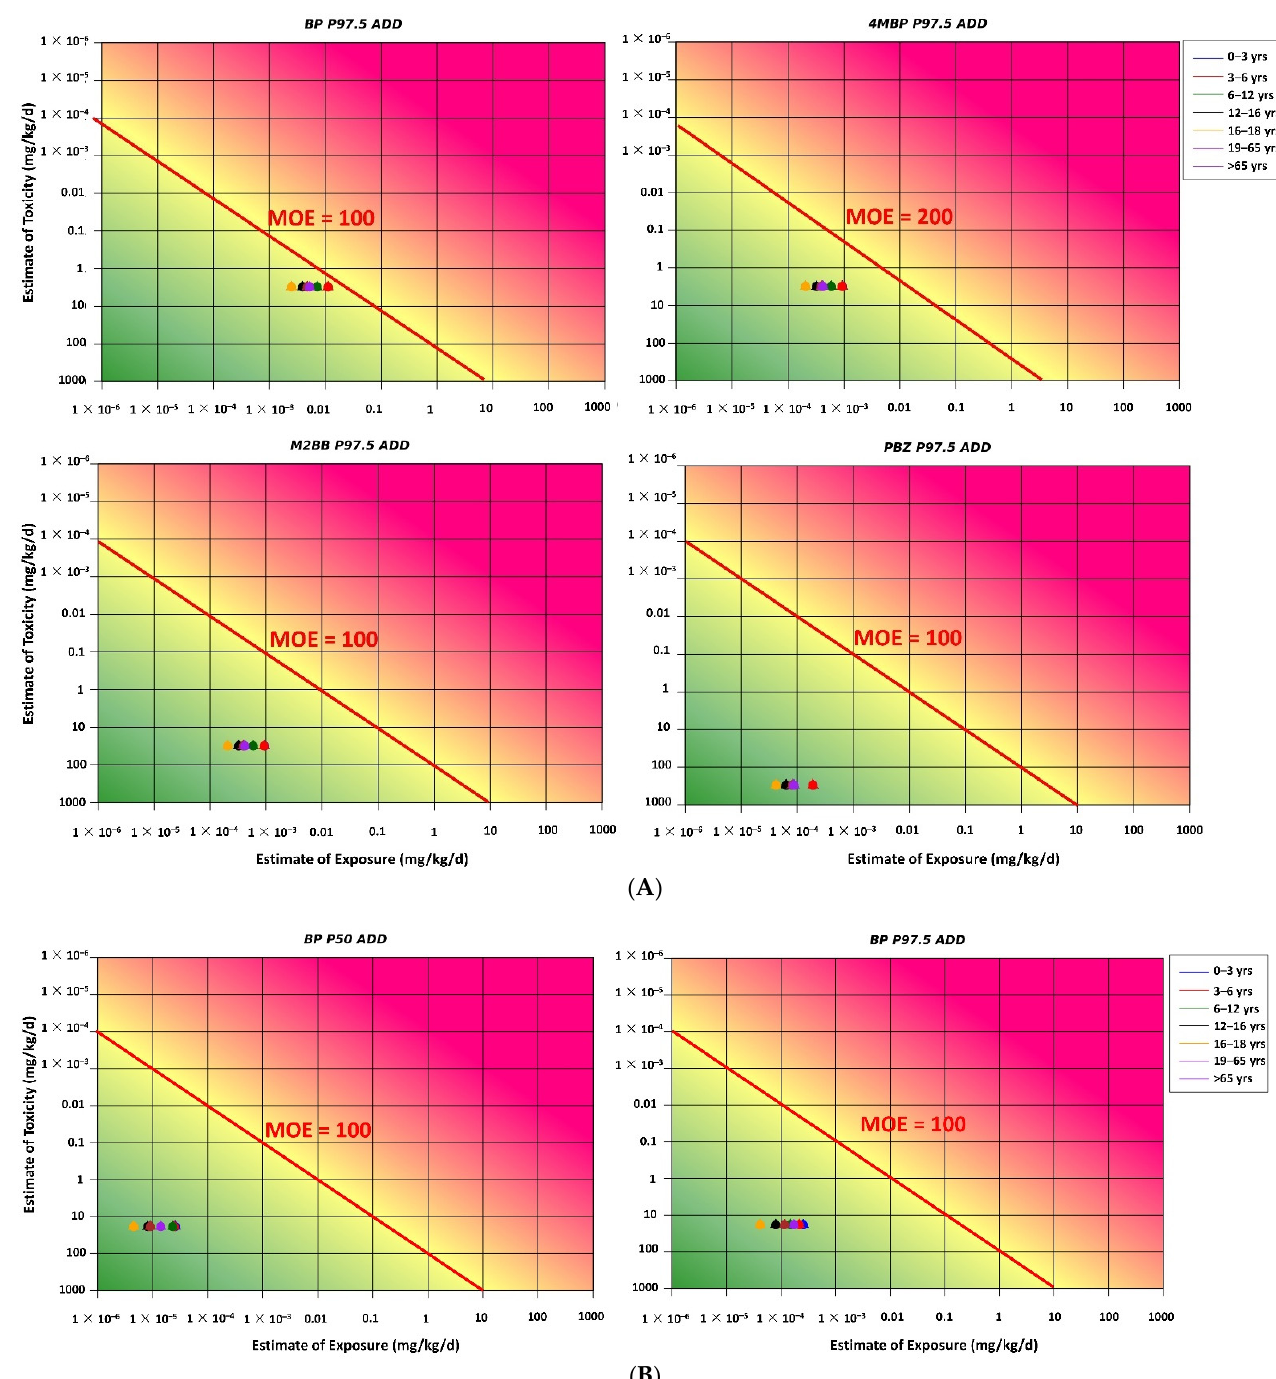
Figure 3. ( A ) Noncarcinogen risk in different age groups determined using the RISK21 matrix (scenario 1). ( B ) Carcinogen risk in different age groups determined using the RISK21 matrix (scenario 1). MOE = margin of exposure; ADD = average daily dose.